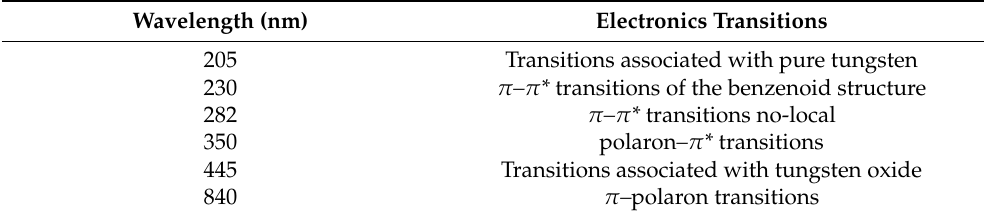
Table 4. UV-VIS energy absorptions of the nanocomposites and the electronic transitions of their constituting